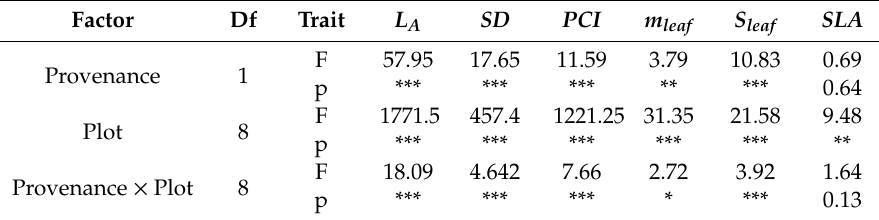
Table 2. Results of two-way ANOVAs for each stomatal and leaf morphological